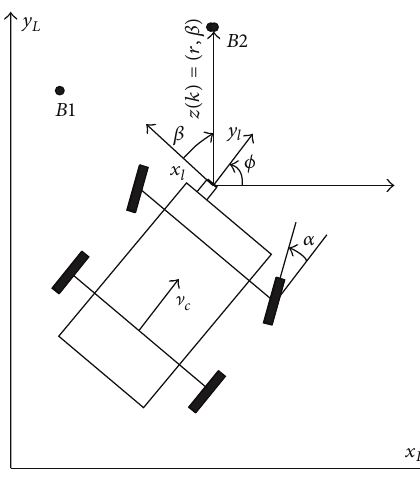
Figure 1: Vehicle